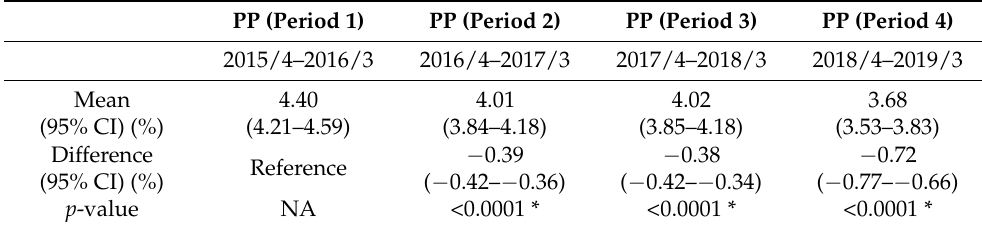
Table 2. Prefecture-based polypharmacy proportion trends over 4 years.